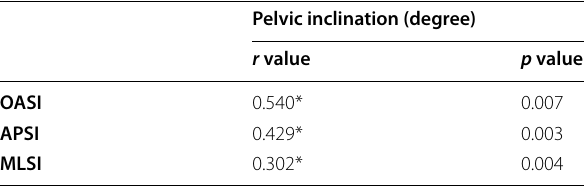
30) Table 4 Correlation between standing balance and pelvic = inclination in studied